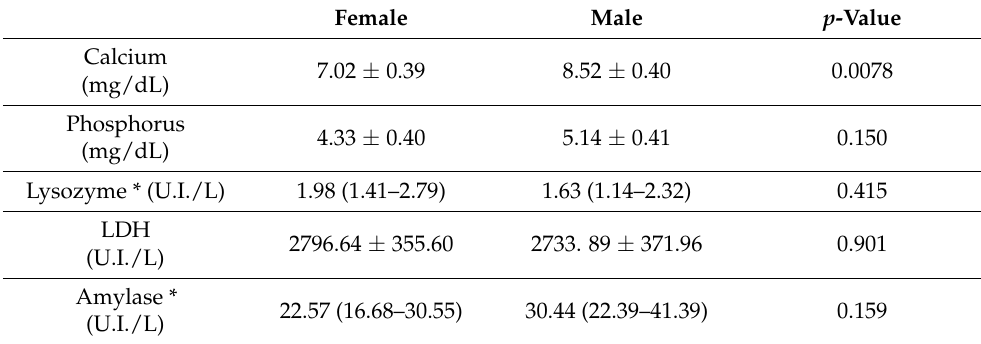
Table 6. Salivary biochemistry (mean ± standard error) in female and male